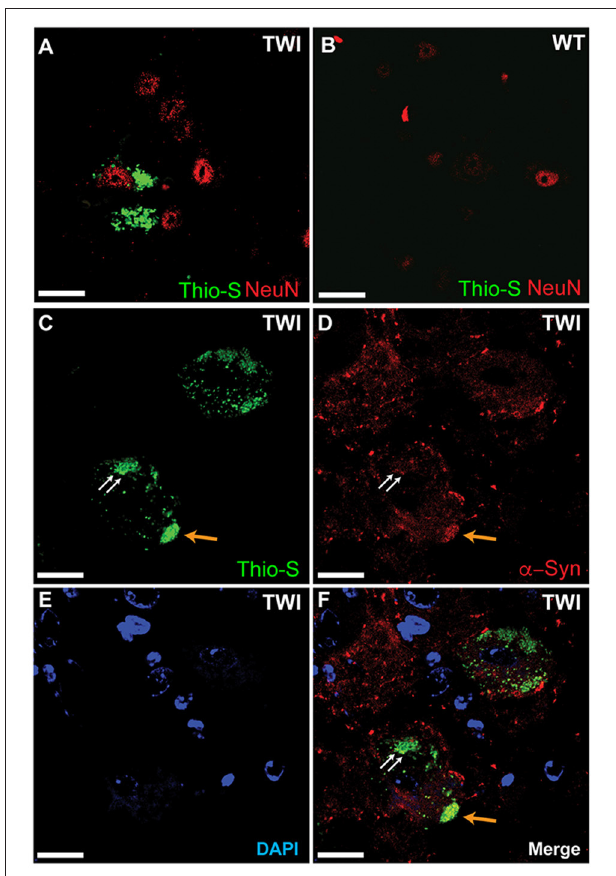
FIGURE 4 | Thioflavin-S accumulations present in neuronal cell populations of spinal cord. Spinal tissue from TWI (A) and WT (B) animals was stained with thioflavin (thio-S) and the neuronal marker NeuN, which found thio-S inclusions within neurons of TWI but not within neurons of WT animals. Dual-staining in TWI with thio-S (C) and alpha-synuclein ( α -syn) (D) revealed colocalization (F) of a-syn with the thio-S inclusions. Cell nuclei are highlighted by DAPI (E) . Scale bars represents (A–F) : 20 µ